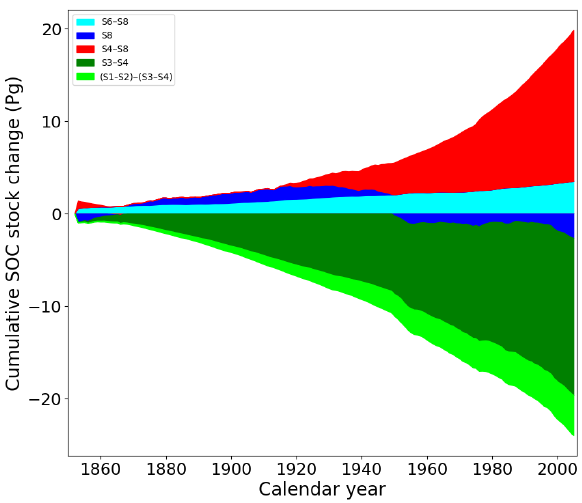
Figure 9. Contribution to the cumulative global SOC stock change over 1850–2005 by CO 2 fertilization (red), by the effect of precip- itation and temperature change on the carbon cycle (dark blue), by the effect of precipitation change on soil erosion ( aqua), by the LUC effect on the carbon cycle (dark green), and by the LUC effect on soil erosion (light